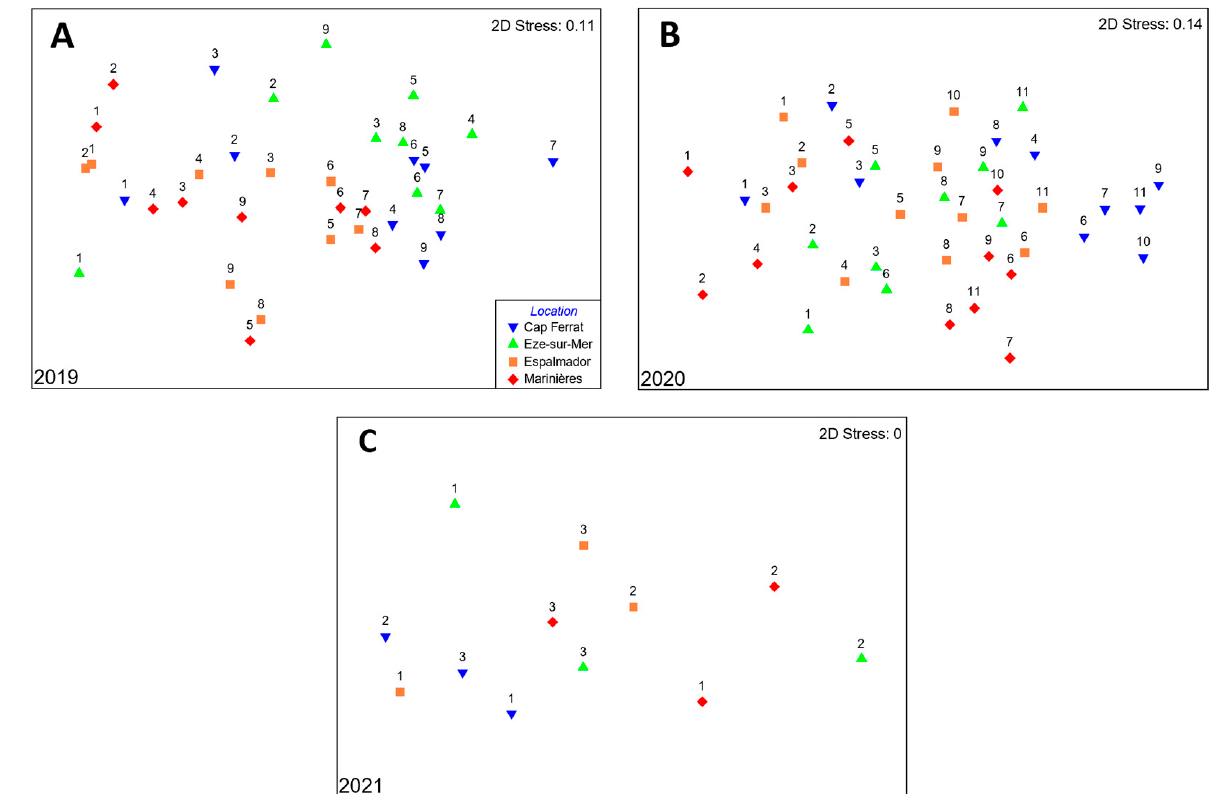
Figure 3. Non-metric multidimensional scaling ordinations (nMDSs) of juvenile sparid assemblages (based on density data) for each study year. In the 2019 ( A ) and 2020 ( B ) nMDS plots, each point corresponds to the centroid of three sites and four transects sampled on each sampling date (labelled with a number) at each location. In the 2021 ( C ) nMDS plot, each point corresponds to a location. The centroids of sites and sampling dates are shown here since the interaction ‘Location × Sampling Date’ was non-significant. Colors and symbols indicate the NI values per location as in the legend.